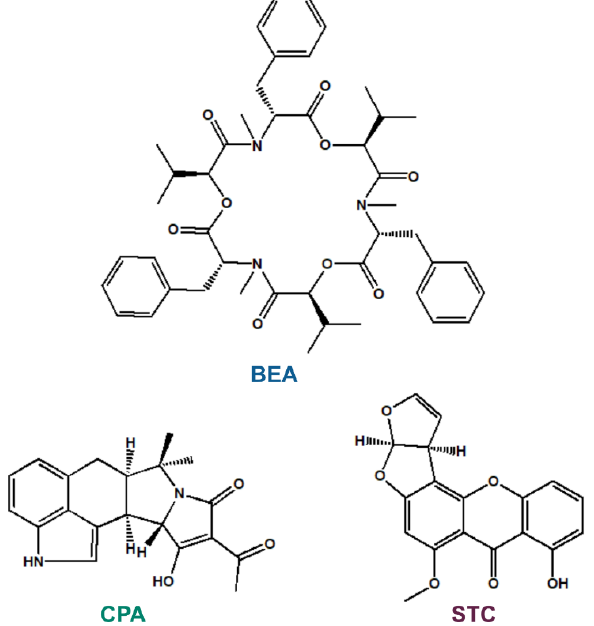
Figure 1. Chemical structures of beauvericin (BEA), cyclopiazonic acid (CPA), and sterigmatocystin (STC).